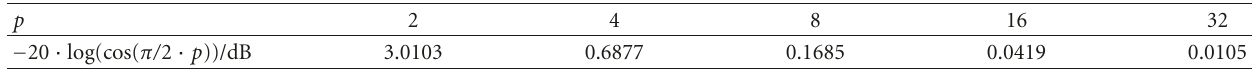
Table 1: Maximum Error over p